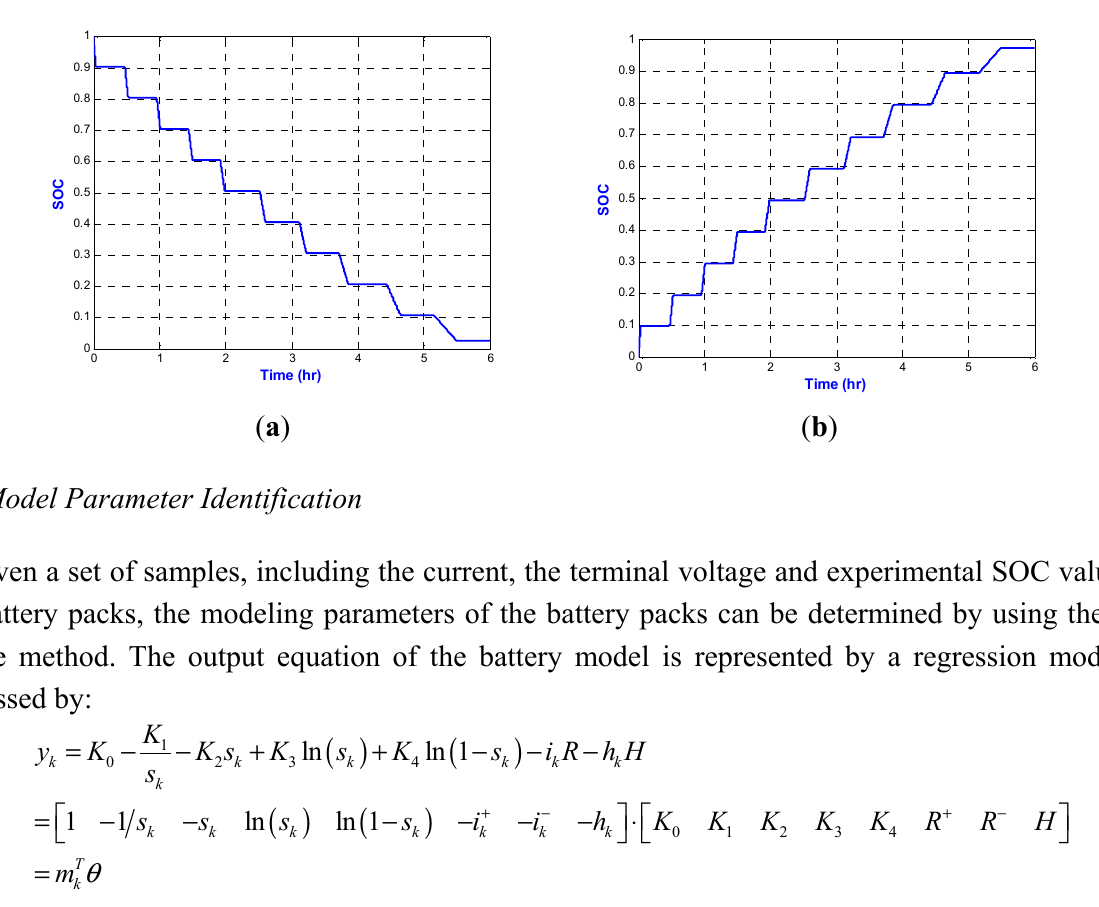
Figure 9. SOC profiles in experiment II. ( a ) Discharge; ( b )